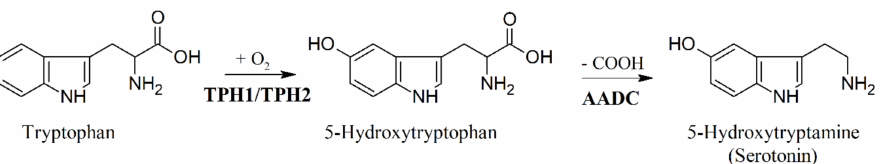
Figure 4. Biosynthetic pathway of serotonin (5-HT). Tryptophan is hydroxylated by the two forms of TPH to yield 5-HTP, which is then decarboxylated by the aromatic amino acid decarboxylase (AADC) to